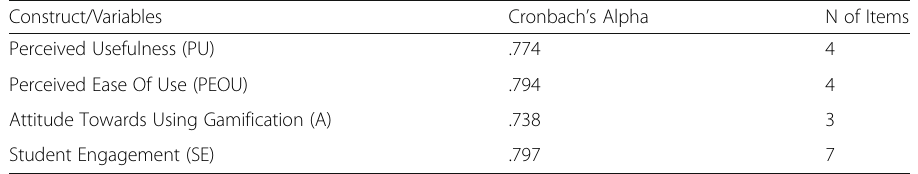
Table 5 Cronbach alpha reliability mesurement